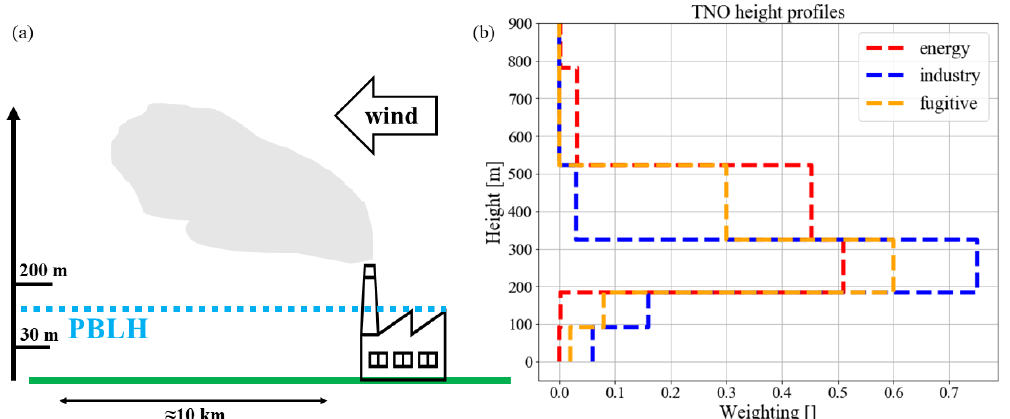
Figure 3. (a) Sketch of a possible nocturnal situation when the planetary boundary layer height (PBLH) lies above the measurement height at 30ma.g.l. but below the exhaust of a nearby power plant stack. (b) TNO height profiles for the public power (energy), industry and fugitive sectors, which were used to calculate the volume influences for the associated point sources. These height profiles are source sector-specific averages, which are representative for